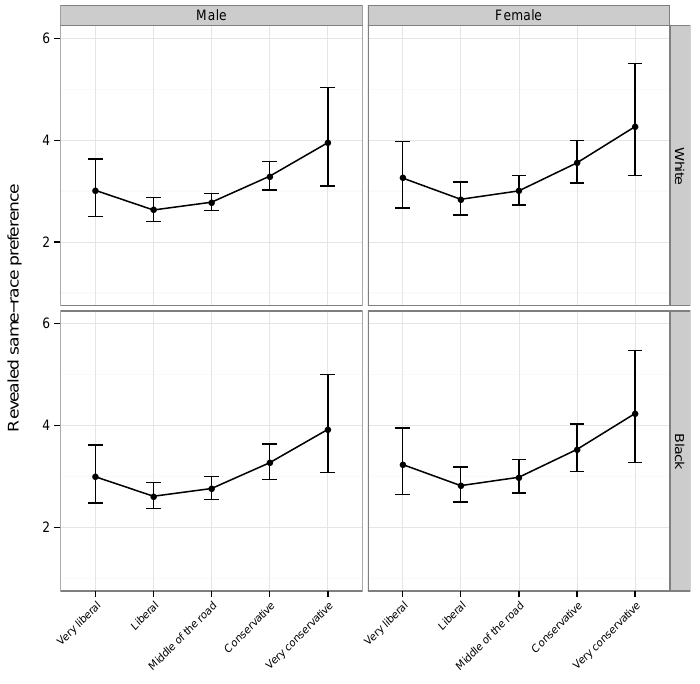
Figure 4: Estimated revealed preferences for same-race partners. Bars indicate 95 percent confidence